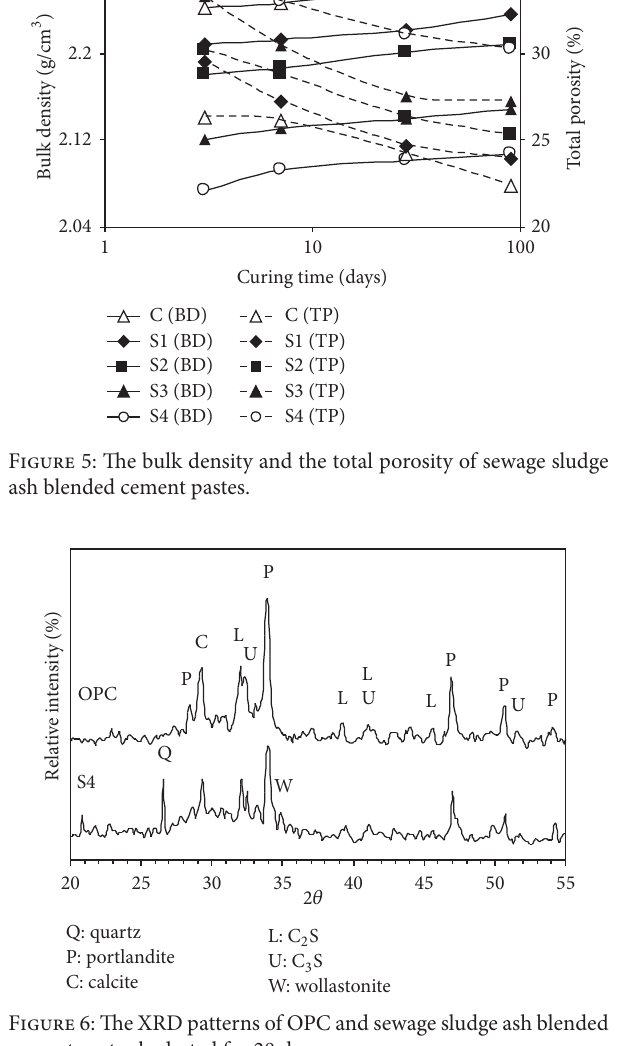
F 6: e XRD patterns of OPC and sewage sludge ash blended cement pastes hydrated for 28 days.